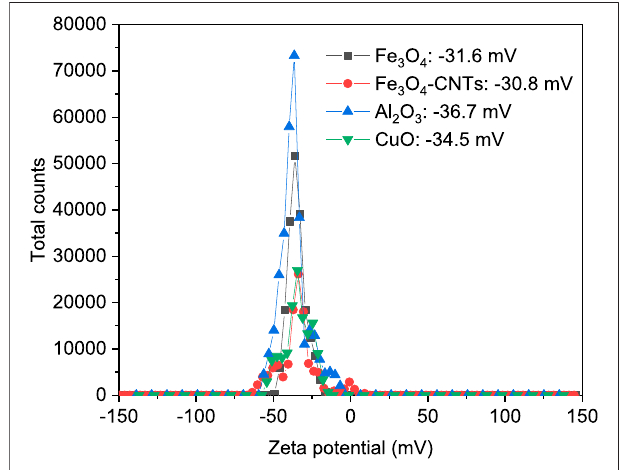
FIGURE 4 | Zeta potential distributions of 1.2 wt% Fe 3 O 4 (Wang et al., 2021a), 1.32 wt% Fe 3 O 4 – CNT (Wang et al., 2021a), 1.0 wt% Al 2 O 3 (Zheng et al., 2020b), and 1.0 wt% CuO (Zheng et al., 2020b) water-based nano fl